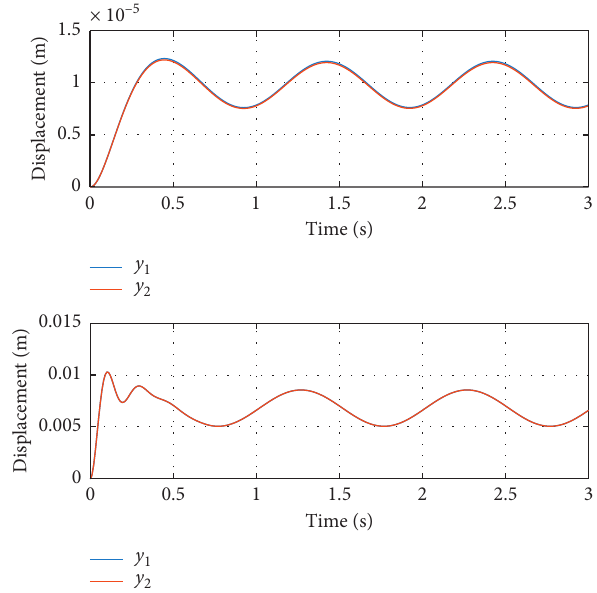
Figure 11: Simulation results under a sinusoidal